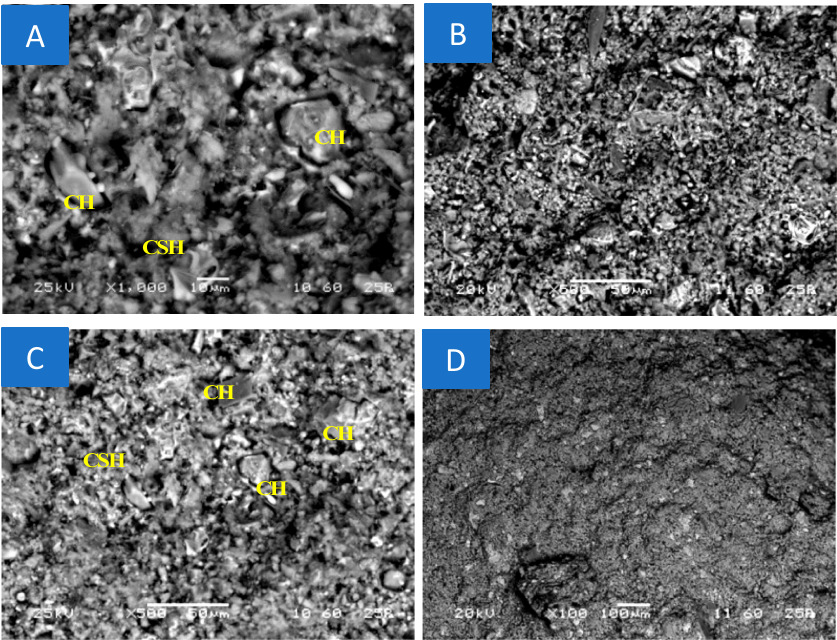
Figure 15. BSC micrograph of B10-PC60LS40 1D at ( A ) 1000× magnification, ( B ) 1000× magnification, ( C ) 500× magnification and ( D ) 100× magnification. Appl. Sci. 2020 , 10 , x FOR PEER REVIEW